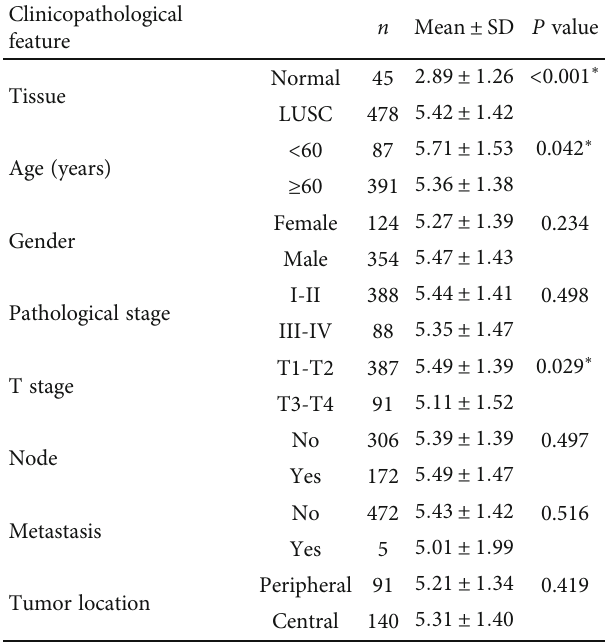
Table 2: Relationship between miRNA-33a-5p expression and clinicopathological parameters of LUSC from